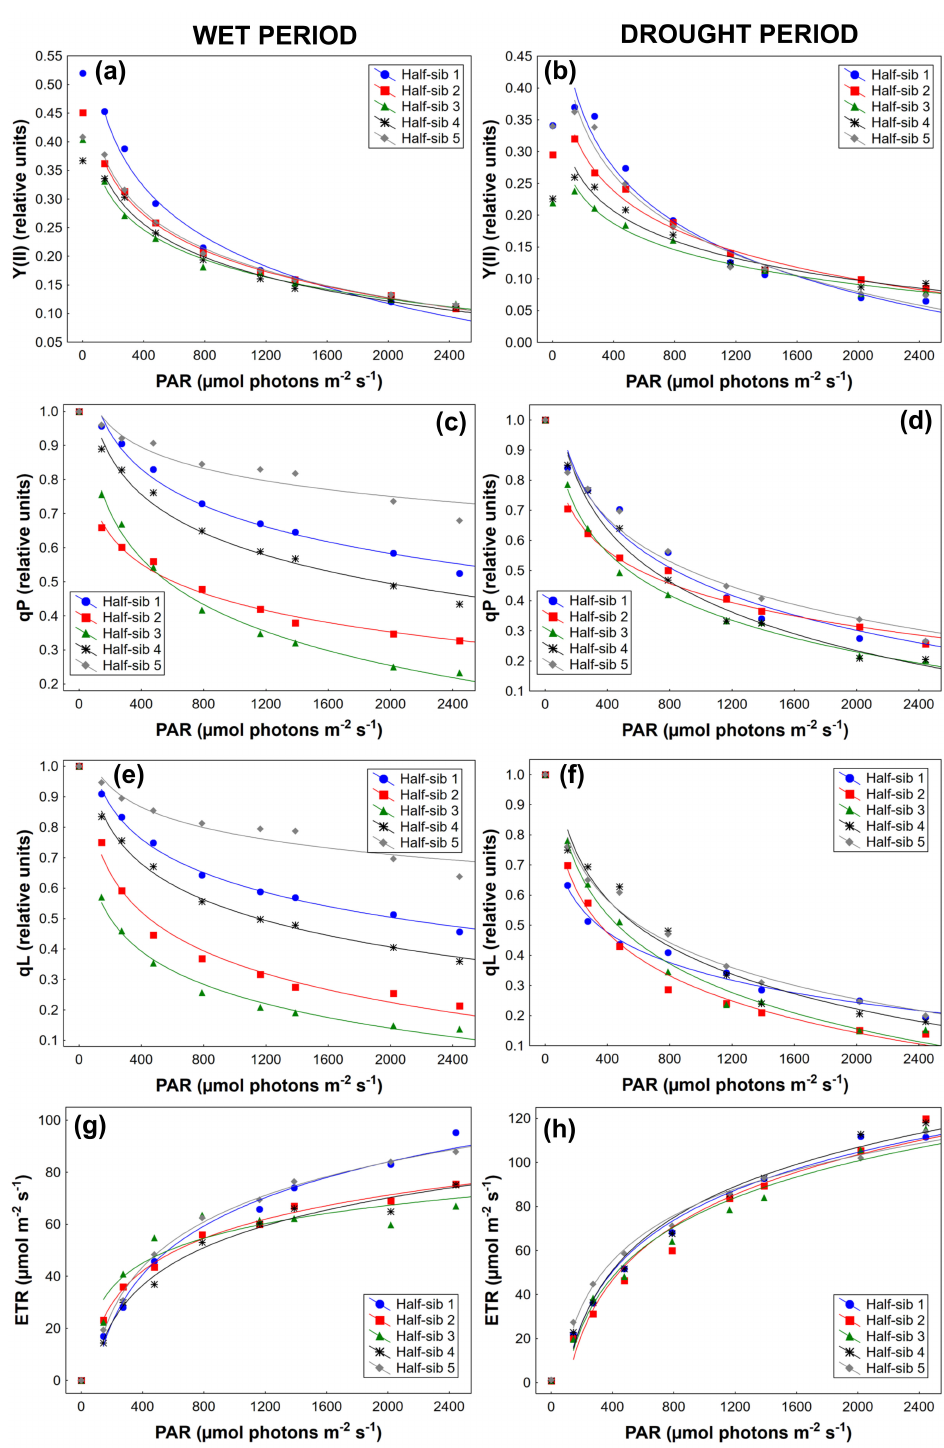
Figure 5. Chlorophyll a fluorescence parameters generated by rapid light curve’s (RLCs) as a function of photosynthetically active radiation (PAR, µ mol photons m − 2 s − 1 ) applied to leaves of five Q. robur half-sib lines during wet and drought periods. ( a , b ) E ff ective quantum yield (e ffi ciency) of PS II photochemistry (Y(II), relative units), ( c , d ) coe ffi cient of photochemical quenching (qP, relative units), ( e , f ) coe ffi cient of photochemical fluorescence quenching assuming interconnected PS II antennae (qL, relative units), ( g , h ) electron transport rate (ETR, µ mol m − 2 s − 1